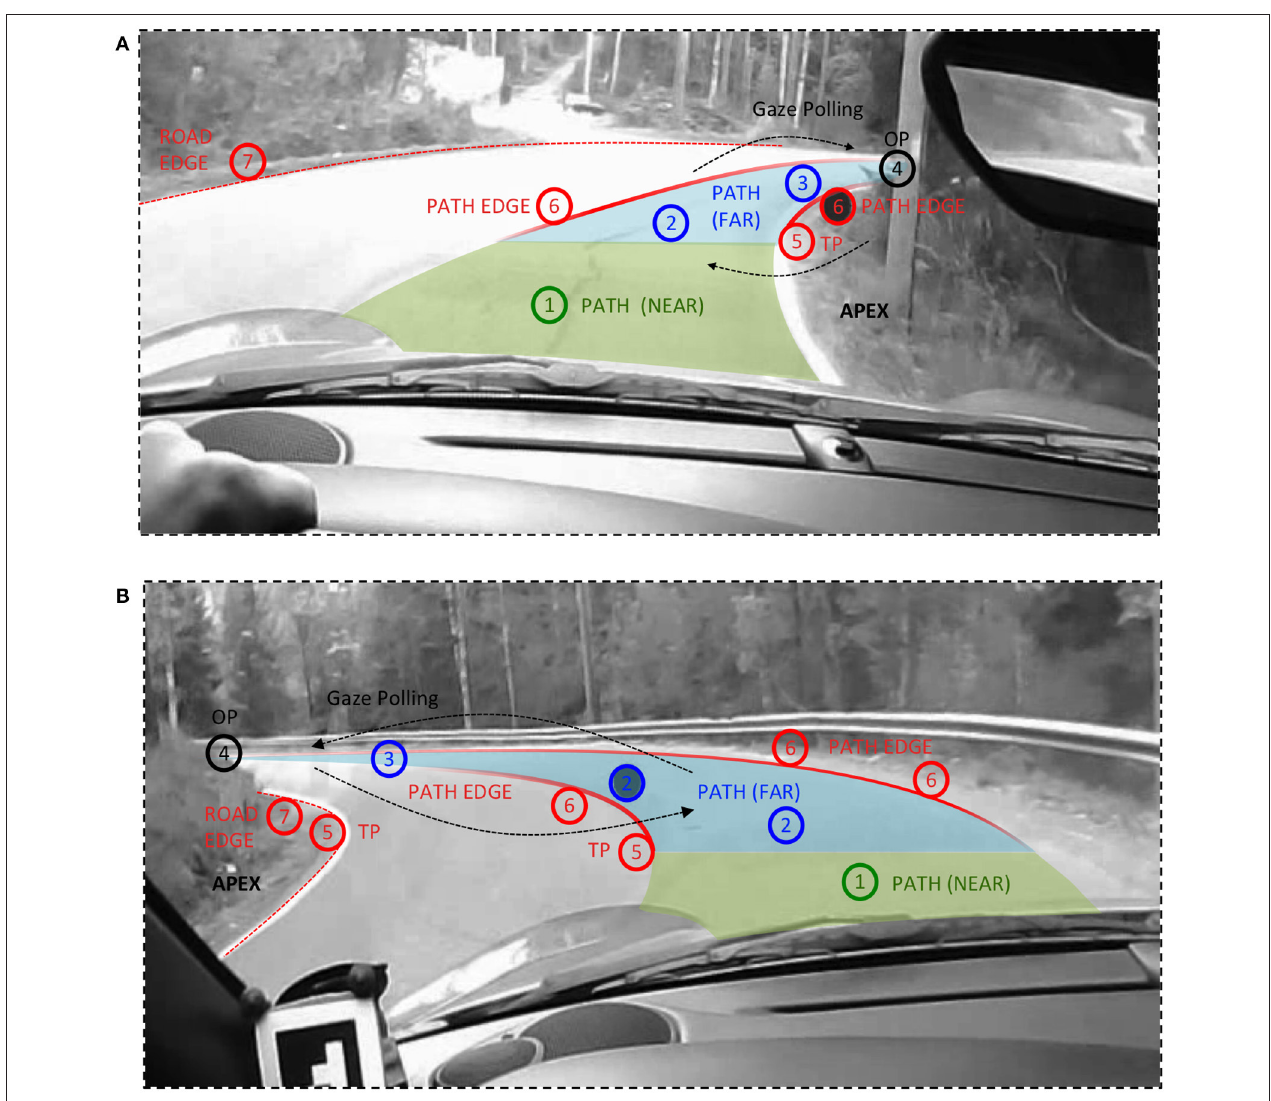
FIGURE 4 | Labeling of fixations at “the road ahead” in curve driving. NB. These underlying road images are the insets from Figures 2B,C . Far Road (blue) is defined as driver’s own lane beyond the tangent point distance. Near Road (green) extends from in front of the vehicle to the tangent point level. (1) Path (near), (2) Path (far), (3) Path (look-ahead), (4) Occlusion Point (look-ahead), (5) Path Edge (tangent point), (6) Path Edge, and (7) Road Edge (tangent